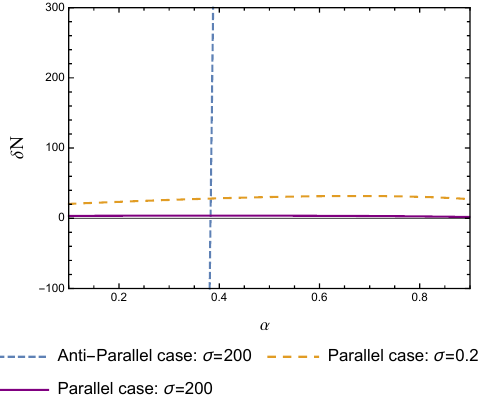
Figure 19 . Parallel and Anti-parallel motions in (1 + 1) dimensions with thermal background: δ N Vs α plot with ∆ E = 1 , A = 10 a B